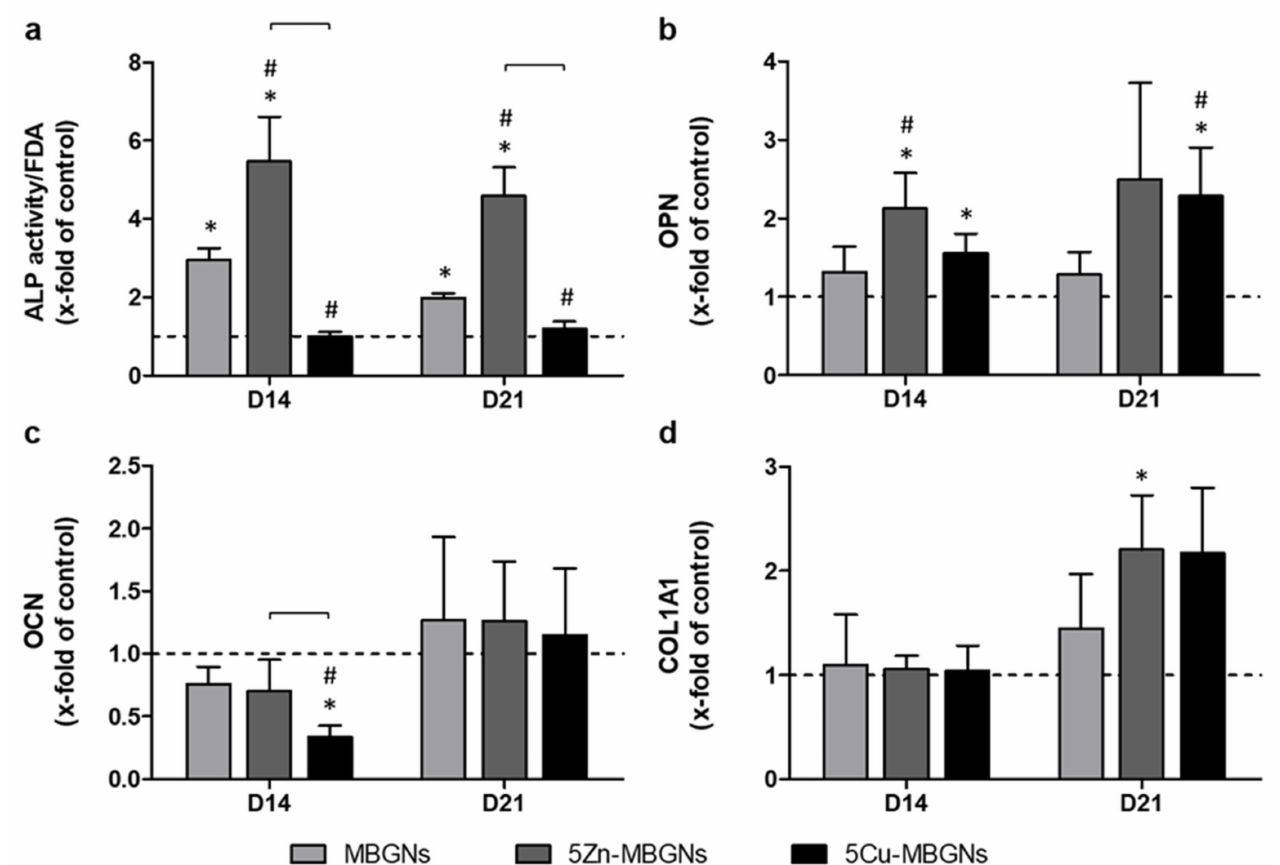
Figure 3. Alkaline phosphatase (ALP) activity of BMSCs (x-fold of control, normalized to fluorescein diacetate (FDA)) ( a ) and expression of genes encoding for relevant members of the extracellular matrix (ECM), namely osteopontin (OPN) ( b ), osteocalcin (OCN) ( c ) and type I collagen alpha 1 (COL1A1) ( d ). Values are normalized to the control group (indicated by the dashed line at y = 1). Significant differences compared to the control group are marked with (*), significant differences compared to MBGNs with (#). Significant differences between the ion-doped MBGNs are highlighted with